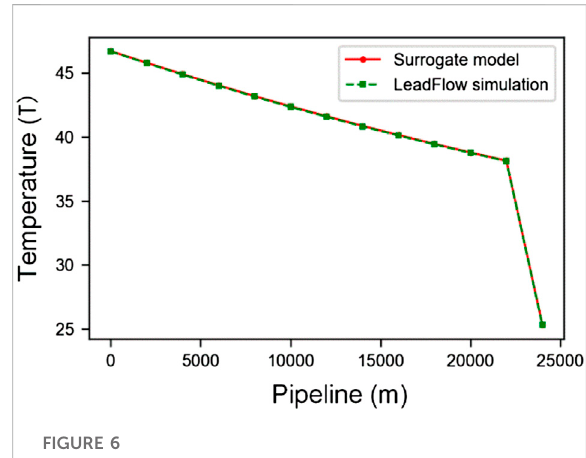
FIGURE 6 The change of temperature along the pipeline between surrogate mode and LeadFlow simulation.